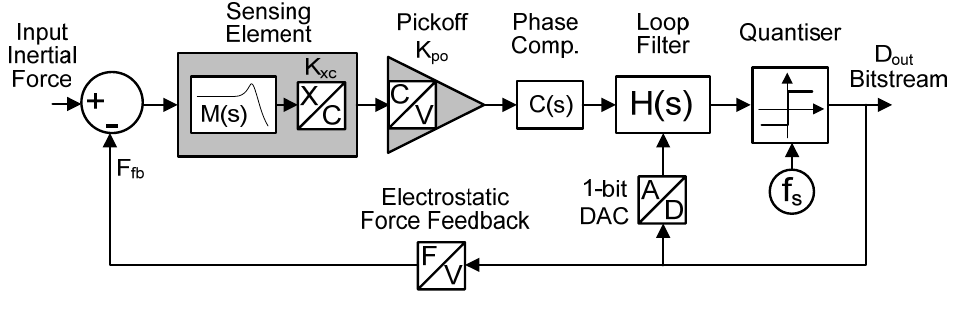
Figure 1. Block diagram of an electro-mechanical sigma-delta